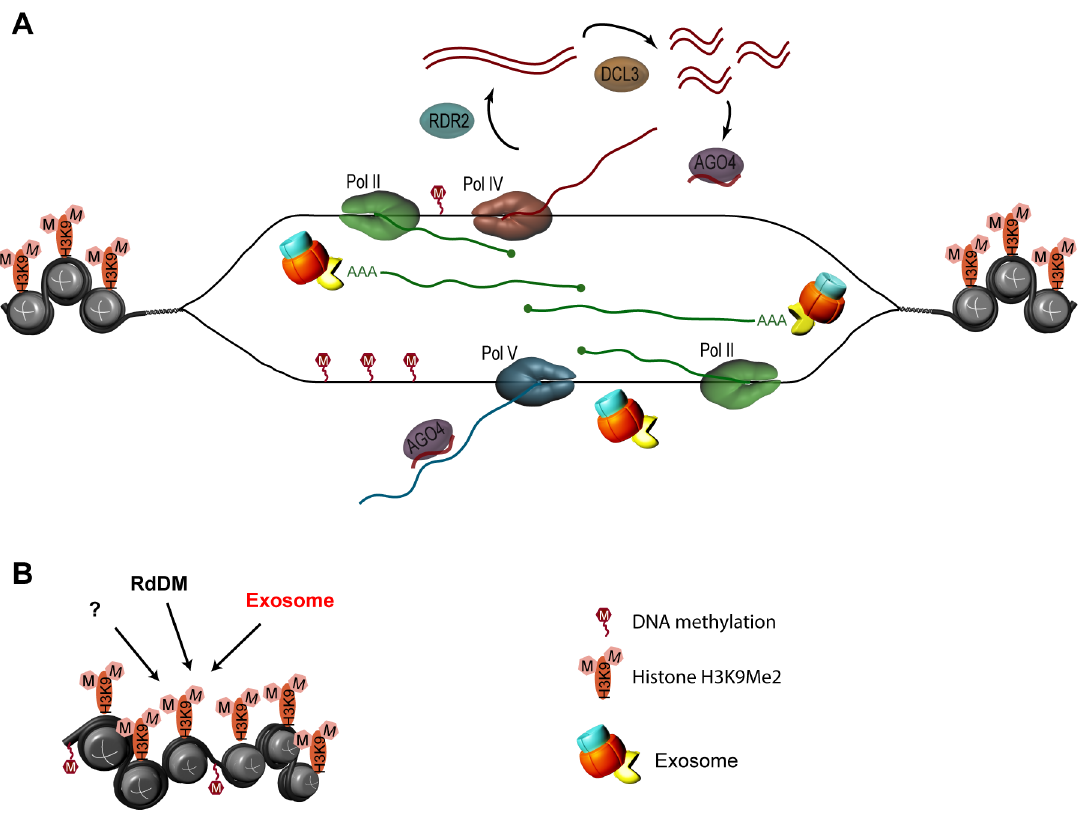
Figure 8. Model for the role of the exosome complex in gene silencing at solo LTR in Arabidopsis . The process of silencing of the solo LTR locus is substantially more complex than portrayed here, but for simplicity only the factors examined in this study are represented. No modifications to the prevailing views on the roles of Pol IV, Pol V, Pol II, RDR2, DCL3, and AGO4 are proposed [9,28,30,31,60]. A. The exosome complex is not involved in the regulation of quality or quantity of siRNAs produced from region A. RNA Pol II (green) generates transcripts from region B of solo LTR. It is also possible that Pol II transcribes both A and B regions in opposite directions. Either Pol II transcripts or the process of transcription from region B recruits Pol V (blue), complexed with AGO4 and siRNA, to the scaffold-producing region B. Due to the sequence complementarity between siRNAs, which are derived from region A only, and the portion of the scaffold transcripts that partially overlaps with region A, AGO4/siRNA RISC localizes to region A and recruits other components of the silencing machinery. Both Pol II and Pol V were implicated in producing region B scaffold transcripts [30,31]. Exosome is not involved in siRNA metabolism and does not contribute to DNA methylation. Exosome participates in controlling the amount of top transcripts emanating from the scaffold-producing region B of solo LTR, and thus may contribute to the repression of region A through regulating the level of region B transcripts. The exosome associates with transcripts emanating from the scaffold-producing region and plays a role in locus silencing through maintaining or establishing chromatin structure. B. More than one silencing pathway controls the solo LTR locus. The exosome associates with transcripts emanating from the adjacent scaffold-producing region, and plays a role in locus silencing through maintaining or establishing chromatin structure by affecting histone methylation (H3K9), in parallel to the RdDM pathway, which affects siRNAs and DNA methylation (‘‘M’’ in red hexagons).